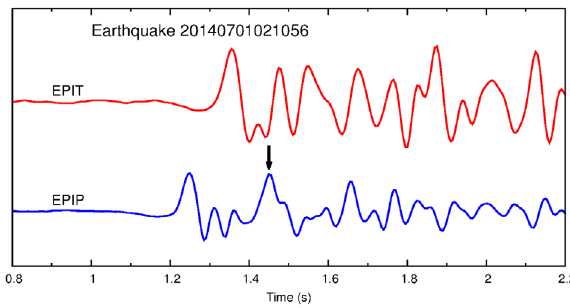
Figure 9. A local earthquake recorded at 130 m depth (EPIP) and at surface (EPIT). The P wave reflected by the free surface (pointed by the arrow) is clearly recognized in the signal recorded at